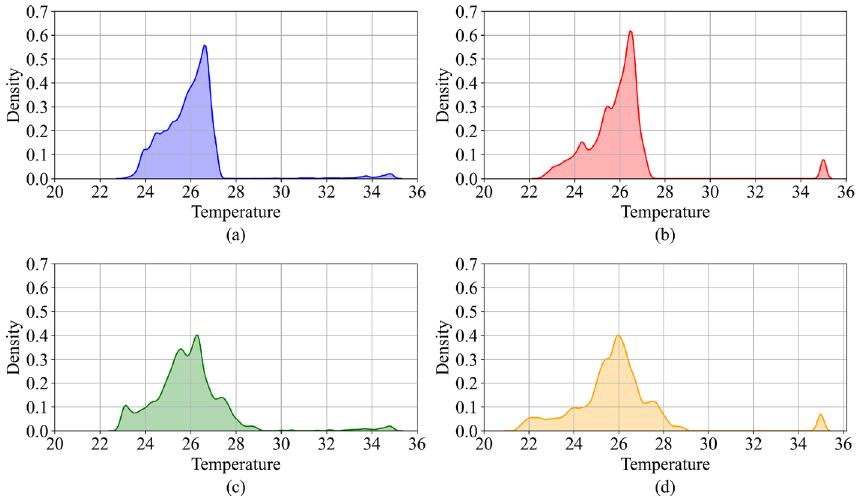
Figure 9. Temperature probability distributions for the frog tongue domain for different simulation parameters. Layer 1, Layer 2, and Layer 3 comprise the 593,769 voxels (blood and tissue) of the domain. Each voxel has a unique temperature. ( a ) ǫ = 10 mm and h b = 10 W m − 2 ◦ C − 1 . ( b ) ǫ = 10 mm and h b = 0.001 W m − 2 ◦ C − 1 . ( c )